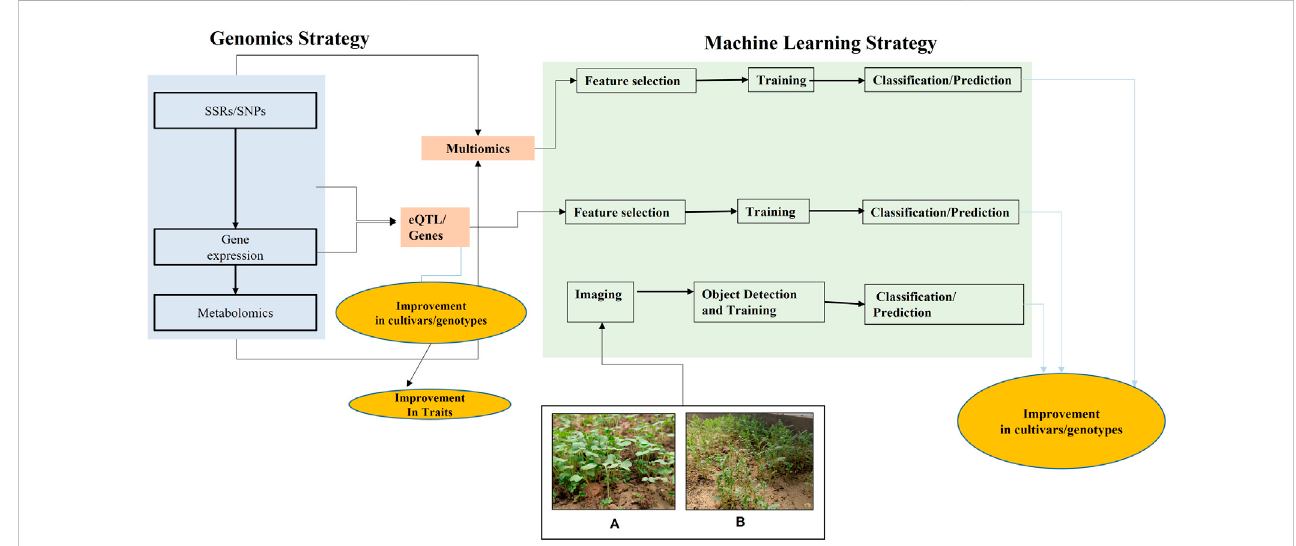
FIGURE 1 Systematic work fl owof OMICSanalysisand itsassociation with machine learning for microgreens improvement and shelf-life prediction: Genomicdata couldbeusedtoexplorethemarkersintheformofSSRs,SNPs.Bulk-RNASeqandmetabolomicsdataprovidesanotherlayerofinformationthatwouldenable Multi-OMICS analysis for cultivation improvement. Machine learning strategies that make the use of both “ numeric ” and “ imaging ” data would enable the development of prediction and classi fi cation